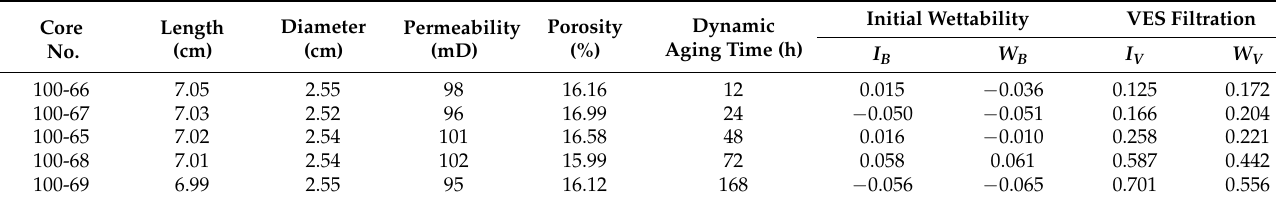
Table 3. Effect of dynamic aging on wettability.